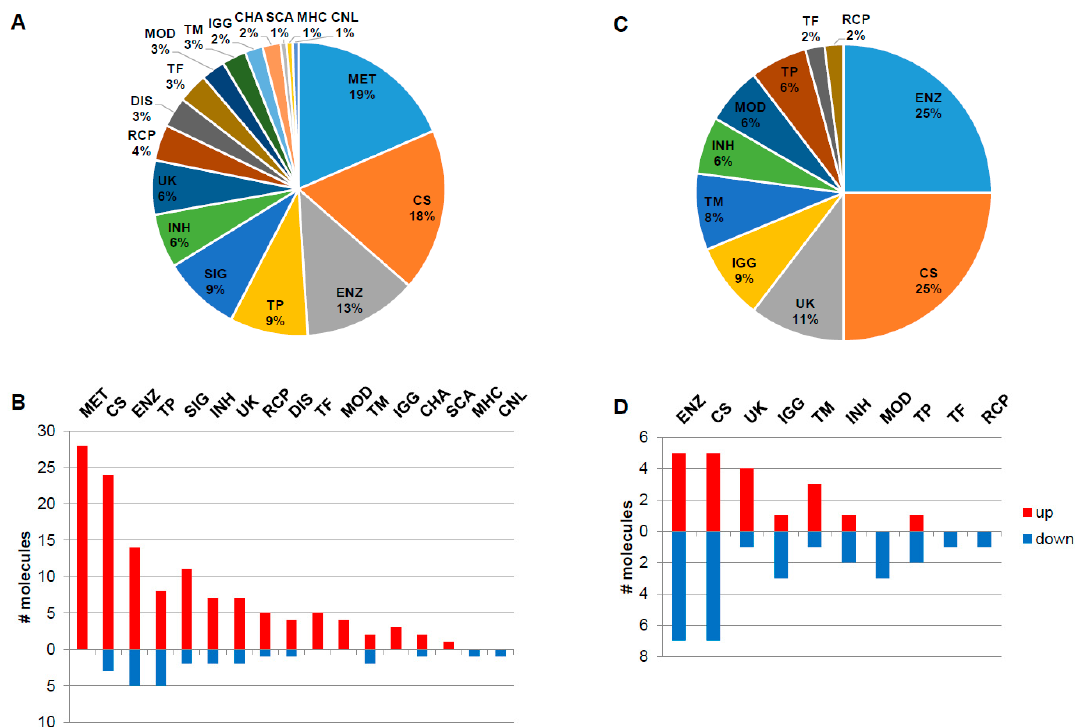
Figure 2. Functionality tag clustering of the total differentially expressed molecules (N = 151, fold-change ≥ 1.4 and p -value < 0.05) reported in the literature for the naïve group ( A ). Associated tags for deregulated molecules: down (N = 26) and up-regulated (N = 125) molecules (fold-change ≥ 1.4 and p -value < 0.05) reported in the literature for the naïve group ( B ). Functionality tag clustering of the total differentially expressed molecules (N = 48, fold-change ≥ 1.4 and p -value < 0.05) reported in the literature for the ERT group ( C ). Associated tags for deregulated molecules: down (N = 28) and up-regulated (N = 20) molecules (fold-change ≥ 1.4 and p -value < 0.05) reported in the literature for the ERT group ( D ). MET: metabolite; CS: Cell shape (cytoskeleton, cell adhesion, morphology, cell junction, cellular structures, extracellular matrix); ENZ: enzyme, enzymatic properties; TP: transport, storage, endocytosis, exocytosis, vesicles; SIG: signalling; INH: inhibitor (protease, kinase, other enzymes, pathways); UK: unknown; RCP: receptor; DIS: disease; TF: transcription and translation, gene regulation; MOD: modulator, regulator; TM: transmembrane; IGG: Immunoglobulin; CHA: chaperone, chaperonin; SCA: scaffolder, docking, adaptor; MHC: major histocompatibility complex component/protein cluster (MHC, HLA); CNL: channel.